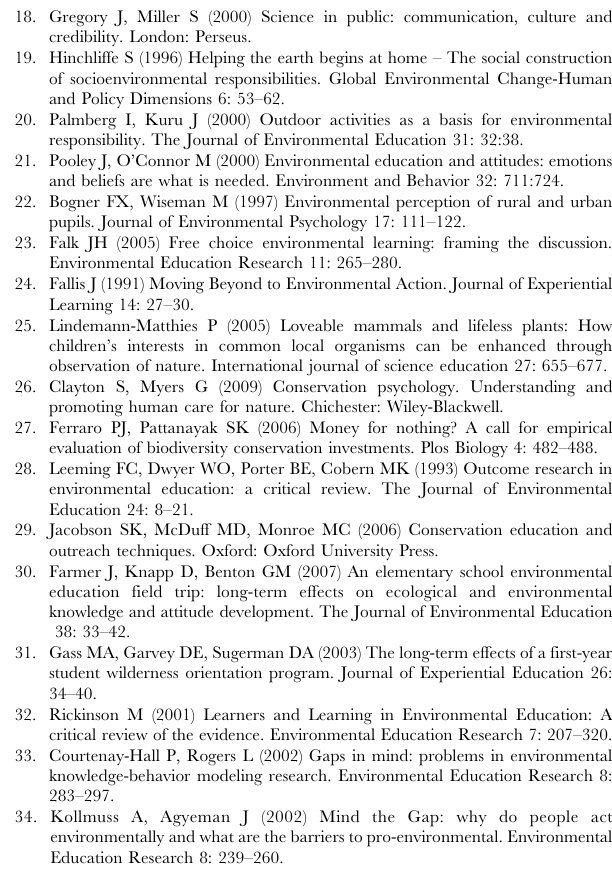
Table S1 Description of the social and pro-environmen- tal profiles of the participants interviewed a few